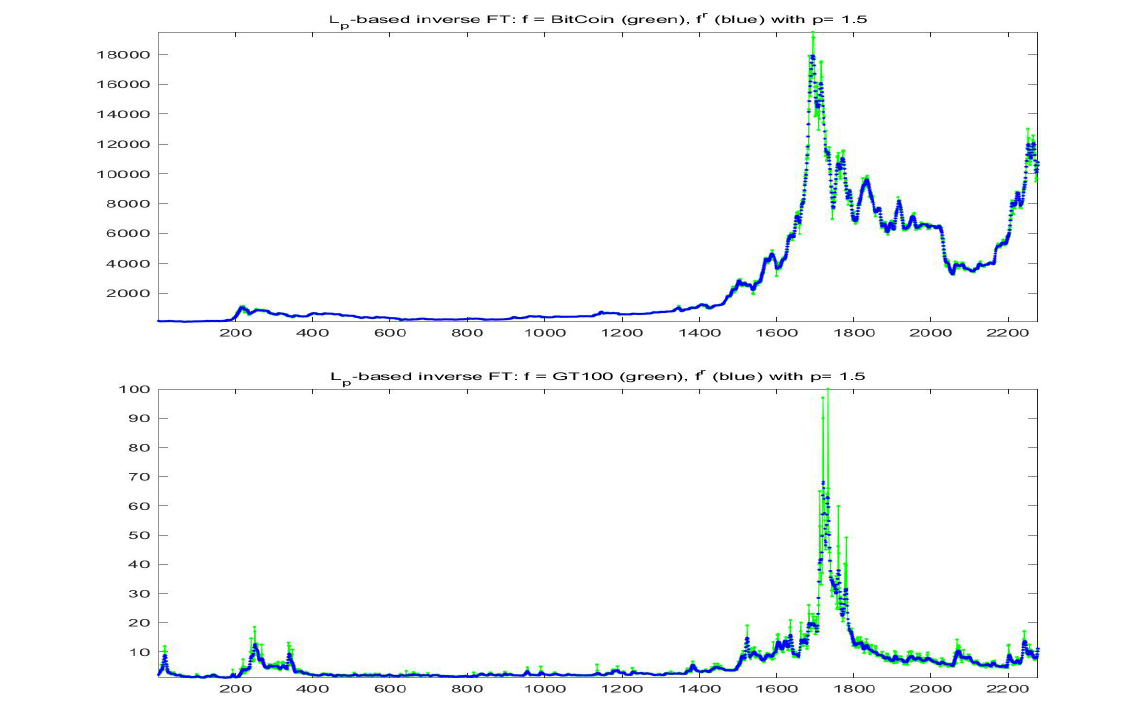
Figure 3. L p -based smoothing for Bitcoin ( top picture, blue points) and GT100 ( bottom , blue points) series, obtained with p = 1.5 and q = 0. The green curves plot the observed series.